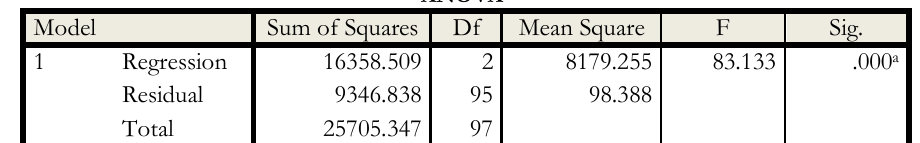
Table 5. Test value